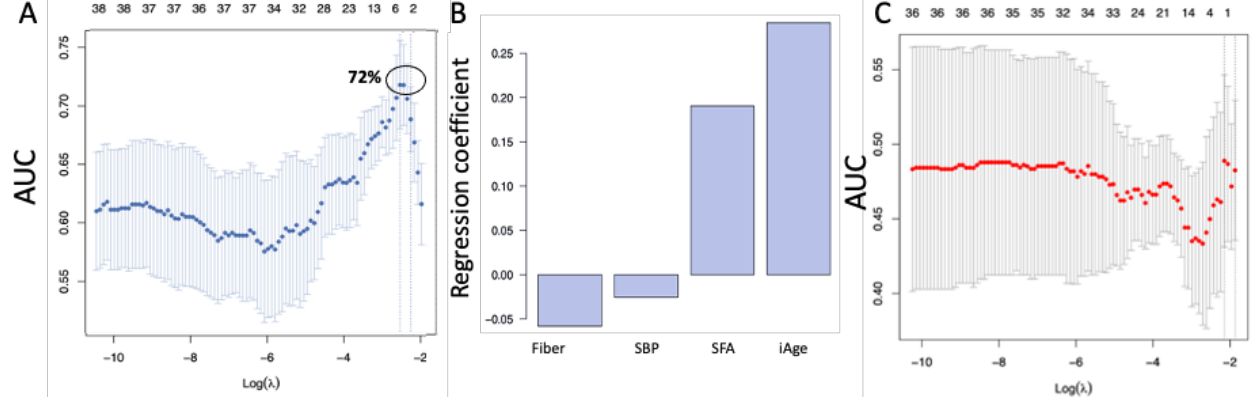
Figure 1. LASSO modeling to identify baseline features that correlate with the change in iAge ® in response to oat product. ( A ) Using the measured baseline traits of individuals in the oats group, LASSO classifier models were trained using a binary outcome of decreased/improvement (1) or increased/worsening (0) iAge ® . Several LASSO models were evaluated with 3-fold cross-validation over varying lambda penalties. The mean accuracy of each lambda-penalized LASSO classifier model, given by the cross-validation area under the curve (cvAUC), was plotted along the y-axis, and the lambda penalty for each model is the x-axis. The indicated best performing LASSO classifier model shows a cvAUC = 0.72. ( B ) The coefficients from the best performing LASSO model from ( A ) were extracted showing the contributions of different metrics towards the prediction of decreased iAge ® . The extracted coefficient values (y-axis) for the four features (x-axis) are plotted in this bar graph. Larger magnitudes of the coefficients (either positive or negative) represent larger roles in dictating the outcome of the LASSO model. ( C ) Multiple LASSO models with different lambda penalties were tested for the placebo-treated control group with 3-fold cross-validation. None of these LASSO models trained on the placebo group delivered a cvAUC score above random (cvAUC > 0.50). iAge ® , Inflammatory Age ® ; SBP, Systolic Blood Pressure; SFA, saturated fatty acid.